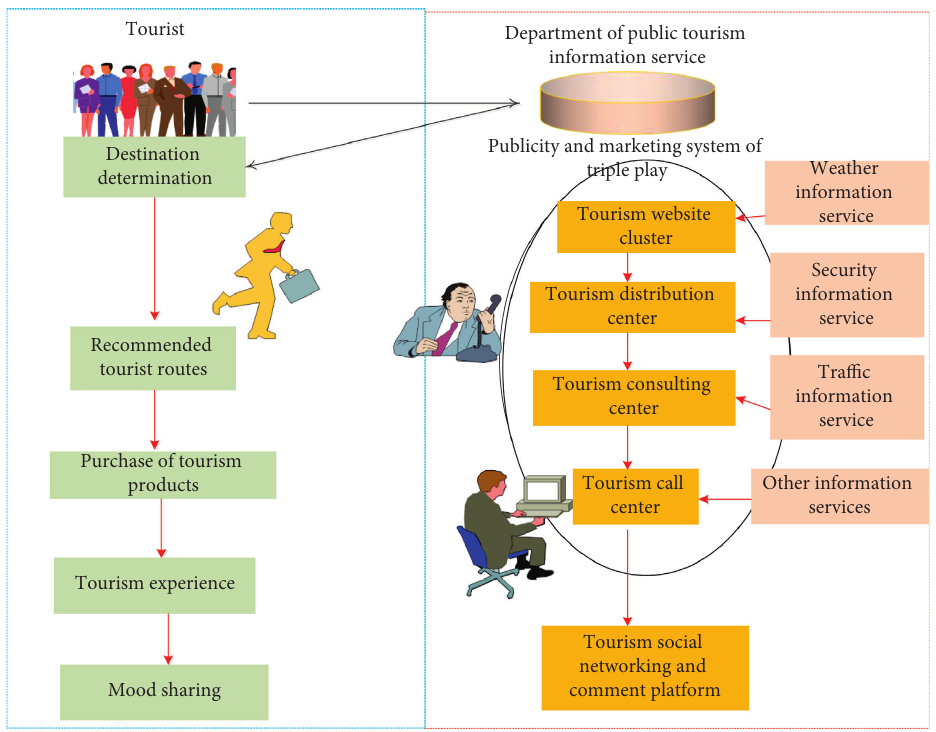
Figure 7: Public tourism information services for smart